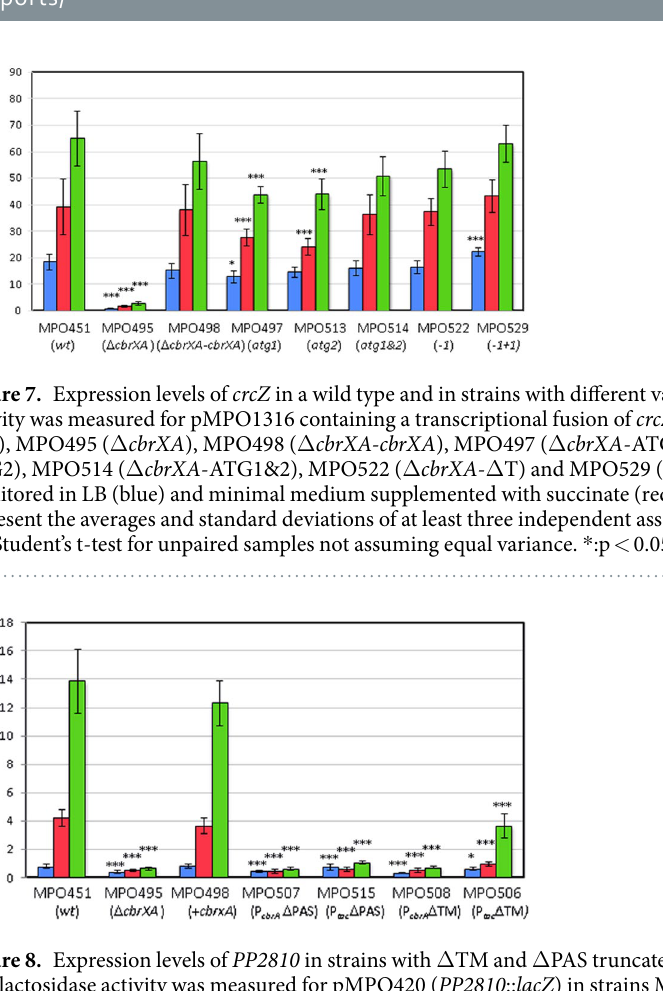
promoter (strain MPO508). On the other hand, if the Δ TM-CbrA form was overproduced by directing its expres- sion by a strong P tac promoter (strain MPO506), the activity was induced 3.8 fold in OAA compared to succinate, and 5.3-fold compared to LB medium, thus suggesting that this form of CbrA is able to activate transcription in response to limited carbon availability. Nevertheless, its induction levels were 3.4-fold lower in OAA and 3.8-fold lower in succinate than the MPO498 strain complemented with the wild type cbrXA sequence (Fig. 8). To estimate the amount of wild type and Δ TM-CbrA proteins produced in these strains, and to detect their subcellular localisation, Ct fusions to gfp were constructed. The corresponding strains producing GFP fusion proteins were analysed by Western blot for the soluble and membrane protein fractions, and confocal microscopy. Complete CbrA-GFP expressed from its own promoter was clearly produced and associated to the membrane fraction (Fig. 9A, lanes 1 and 3). Overproduction of this protein by using the strong P tac promoter resulted in moderately higher production of CbrA-GFP, which was also associated to the membrane fraction. On the other hand, production of the Δ TM-CbrA-GFP version from the P cbrA was not readily detectable (Fig. 9A, lanes 7 and 8), while its production was highly increased when expressed from P tac (Fig. 9A, lanes 5–6). The Δ TM-CbrA protein overexpressed from P tac (Fig. 9A, lane 6) clearly accumulated in the soluble fraction when compared to the full CbrA in the same conditions (Fig. 9A, lane 2). Since the membrane fractions were 10-fold concentrated in relation to the soluble fractions to normalise the amount of total protein loaded onto the Western Blot, a fraction of the Δ TM-CbrA was also visible for the insoluble fraction when overexpressed (Fig. 9A, lane 5). This obser- vation is probably also due to incomplete cell breakage or partial aggregation of the protein in inclusion bodies. Confocal microscopy of the strain producing CbrA-GFP from its own promoter (MPO520) showed a sub- cellular localisation of the protein clustered in foci at the surface of the cell, probably inserted in the membrane (Fig. 9B, left). On the other hand, the Δ TM-CbrA produced in the same conditions (MPO521) did not position itself in condensed loci and was dispersed in the cytosol (Fig. 9B, right).